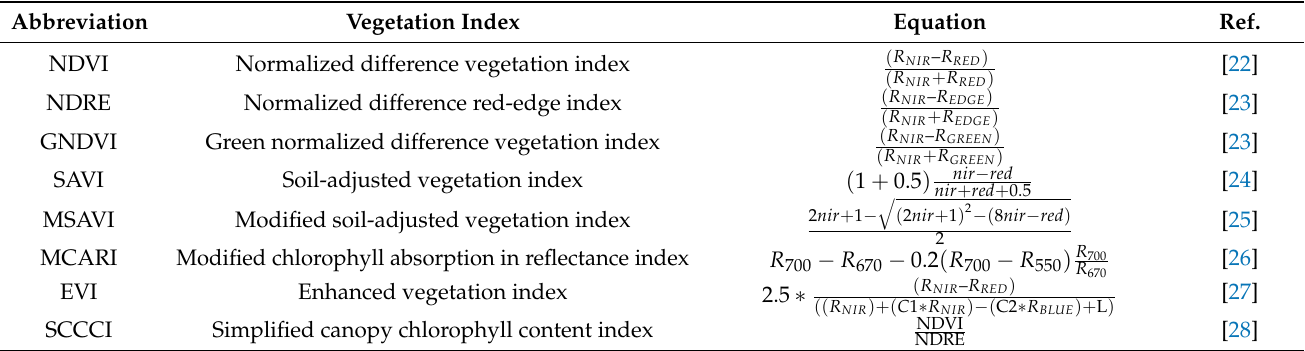
Table 1. List of vegetation indices used in the